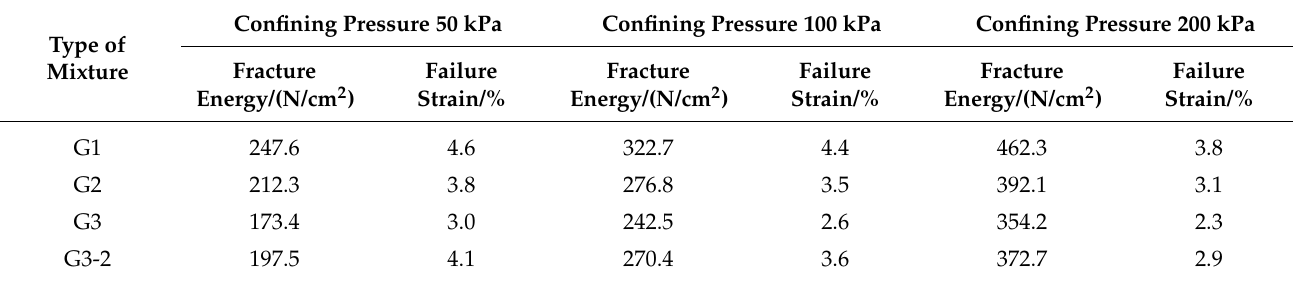
Table 7. Results of fracture energy and failure strain for the mixtures.